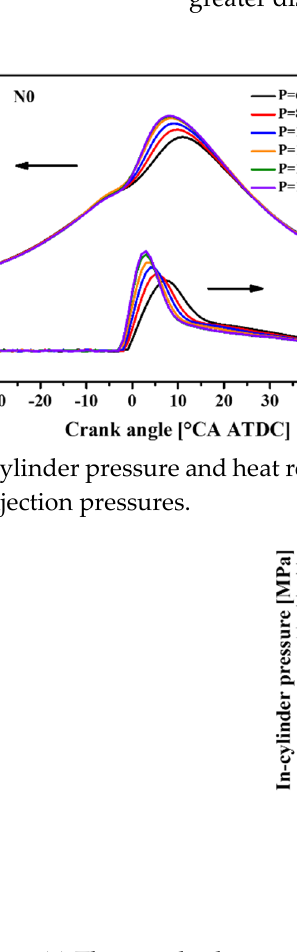
( c ) The in-cylinder pressure and heat release rate of N5 at different injection pressures. Figure 2. Variation of in-cylinder pressure and heat release rate with respect to injection pressure for n -octanol/diesel blends.